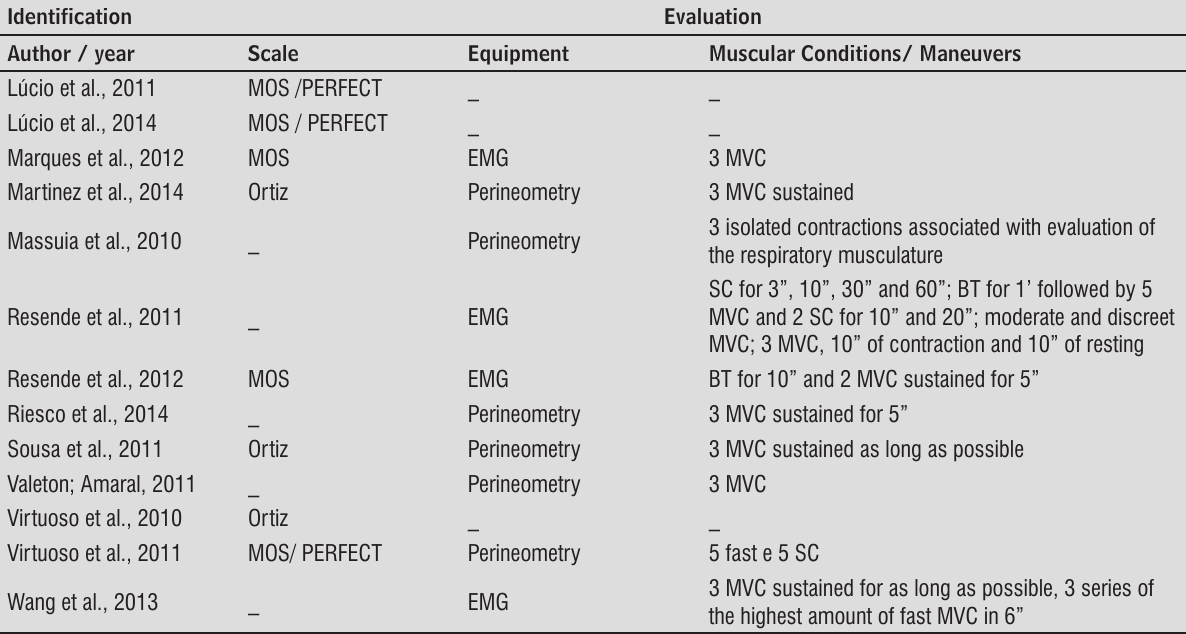
Table 1 - Clinical functional evaluation of PF present in